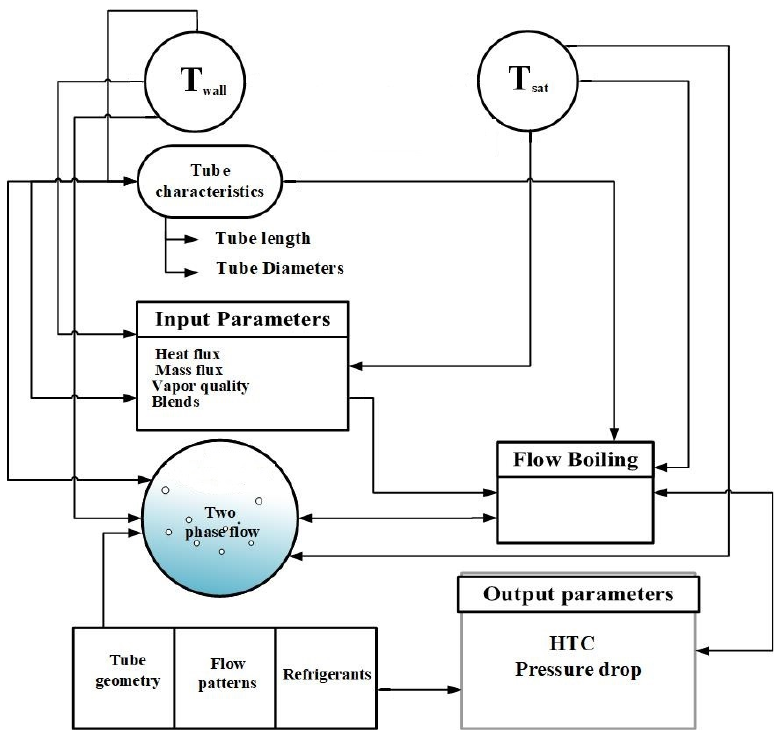
Figure 3. Inter-dependency of the flow boiling with different parameters.